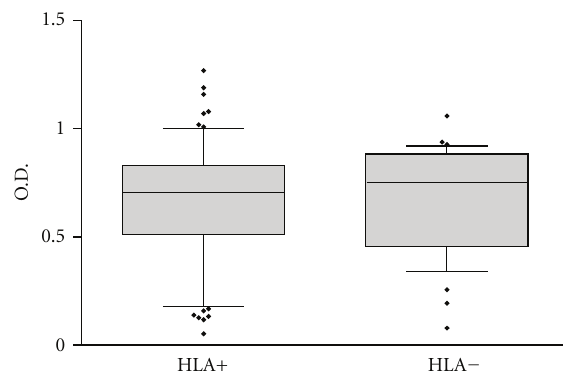
Figure 1: Direct ELISA for total IgG reactivity to recombinant B13 protein in the solid phase. 76 subjects bearing HLA alleles capable of presenting B13 peptides to T cells HLA-DQ7, DR1, and DR2 (HLA+), and 36 subjects bearing other HLA alleles (HLA − ). The horizontal bar indicates median absorbance in each group. P = 1 . 00, Mann-Whitney Rank Sum Test .